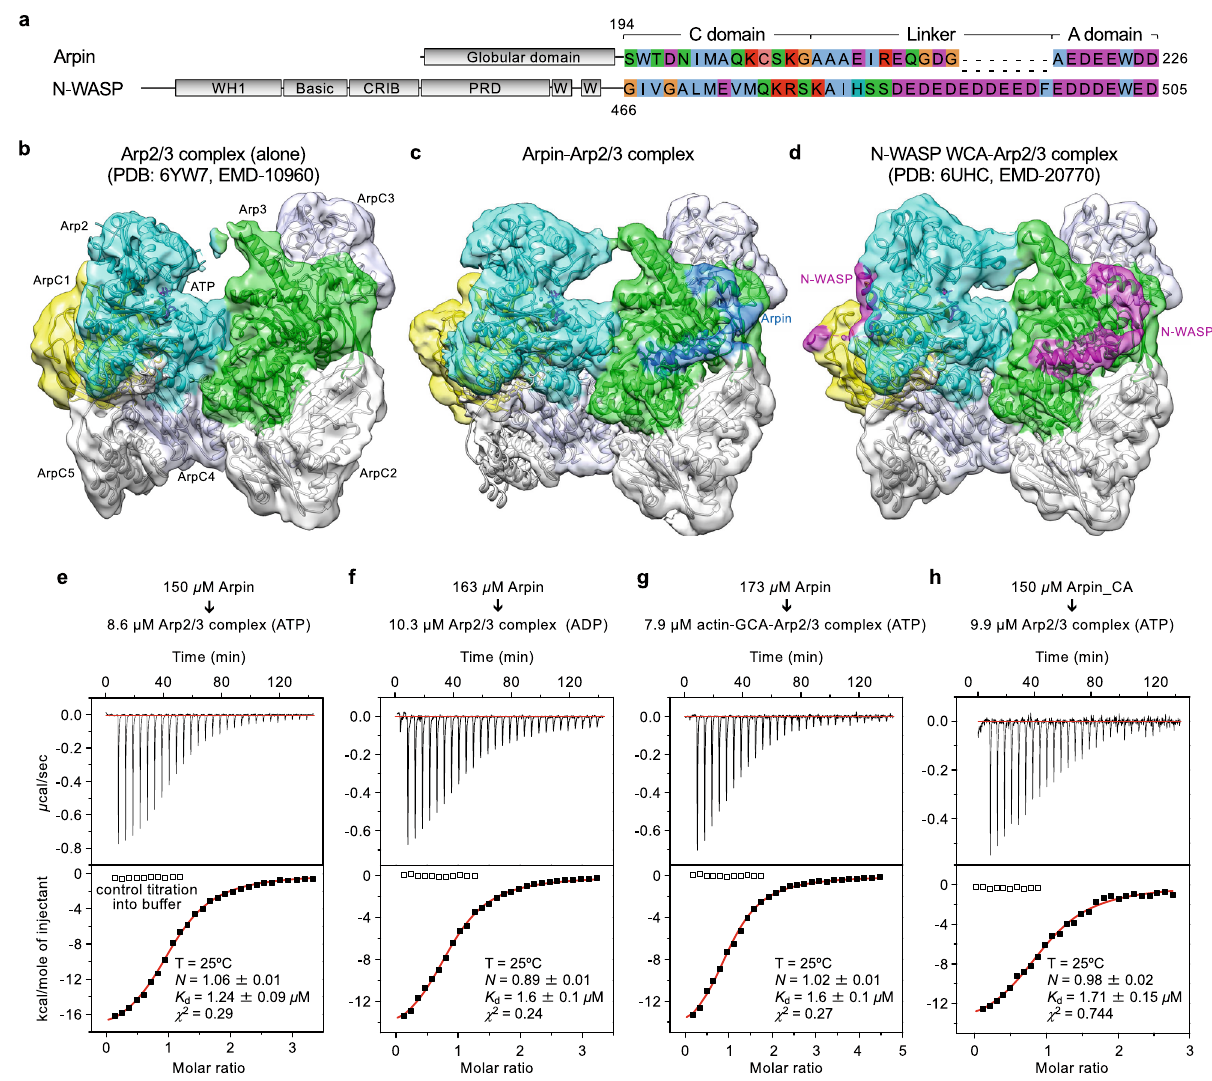
Fig. 1 Arpin binds to a single site on subunit Arp3 of Arp2/3 complex. a Comparison of the domains and sequences of N-WASP (NPF) and Arpin (inhibitor), both of which contain C-terminal CA regions (UniProt accession codes: human N-WASP, O00401 and human Arpin, Q7Z6K5). b – d Comparison of cryo-EM maps (and ribbon diagrams) low-pass fi ltered at the 5-Å resolution of Arp2/3 complex alone 15 ( b ) and with bound Arpin ( c ) and N-WASP CA 7 ( d ). Arp2/3 complex subunits are labeled in part b, and colored as follows: Arp2, cyan; Arp3, green; ArpC1, yellow; ArpC2, gray; ArpC3, blue-white; ArpC4, blue-white; ArpC5, gray. Arpin and N-WASP are colored marine blue and magenta, respectively. Note that the Arpin_CA and N-WASP CA densities on Arp3 are very similar. Panels b – d were generated with the program Chimera 41 , and the maps were contoured at 4 σ . e – h ITC titrations of full-length Arpin or Arpin_CA (in the syringe) into Arp2/3 complex (in the cell) in the ATP or ADP-bound states (as indicated). For each titration, the experimental conditions, including temperature (T) and protein concentrations, and the fi tting parameters, including stoichiometry ( N ), dissociation constant ( K d ), and goodness of the fi t ( χ 2 ) are